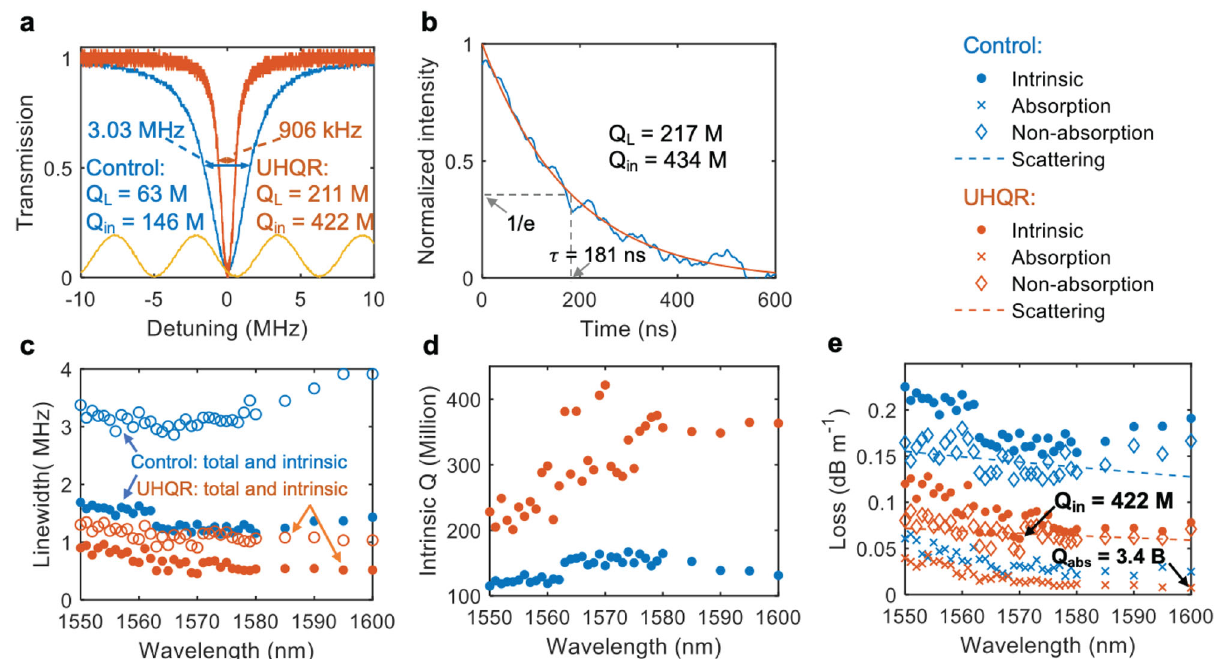
Fig. 2 Linewidth, ring-down, and photo-thermal absorption loss measurements of the UHQR and control devices. a Spectral scan of the fundamental 1570 nm transverse electric fi eld (TE) mode for the control (blue curve) and ultra-high quality factor ( Q ) resonator (UHQR) (orange curve) devices. The total and intrinsic linewidths are extracted from a Lorentzian fi t. The yellow sinusoidal signal is a radio frequency (RF) calibrated fi ber Mach-Zehnder interferometer (free spectral range (FSR) = 5.871 ± 0.004 MHz, see the Supplementary Information). M, Million. b UHQR ring-down time ( τ ) measurement at 1570 nm with calculated loaded and intrinsic Q factors ( Q L and Q in ). The experimental data (blue curve) is fi tted with an exponential curve (orange curve). c Summary of the total (blue circle) and intrinsic (blue dot) linewidths for the control and total (orange circle) and intrinsic (orange dot) linewidths for the UHQR devices from 1550 nm to 1600 nm. d Measured intrinsic Q from 1550 nm to 1600 nm for the control (blue dot) and UHQR (orange dot) resonators. e Photo-thermal absorption loss measurement from 1550 nm to 1600 nm for UHQR and control. The highest UHQR 422 Million intrinsic Q at 1570 nm and the absorption-limited Q ( Q abs ) of 3.4 Billion at 1600 nm are indicated. The non-absorption loss is fi t to the surface scattering loss model (dash lines). The blue dot, cross, and diamond data represent the intrinsic, absorption, and non-absorption losses for the control resonators. The orange dot, cross, and diamond data represent the intrinsic, absorption, and non-absorption losses for the UHQR